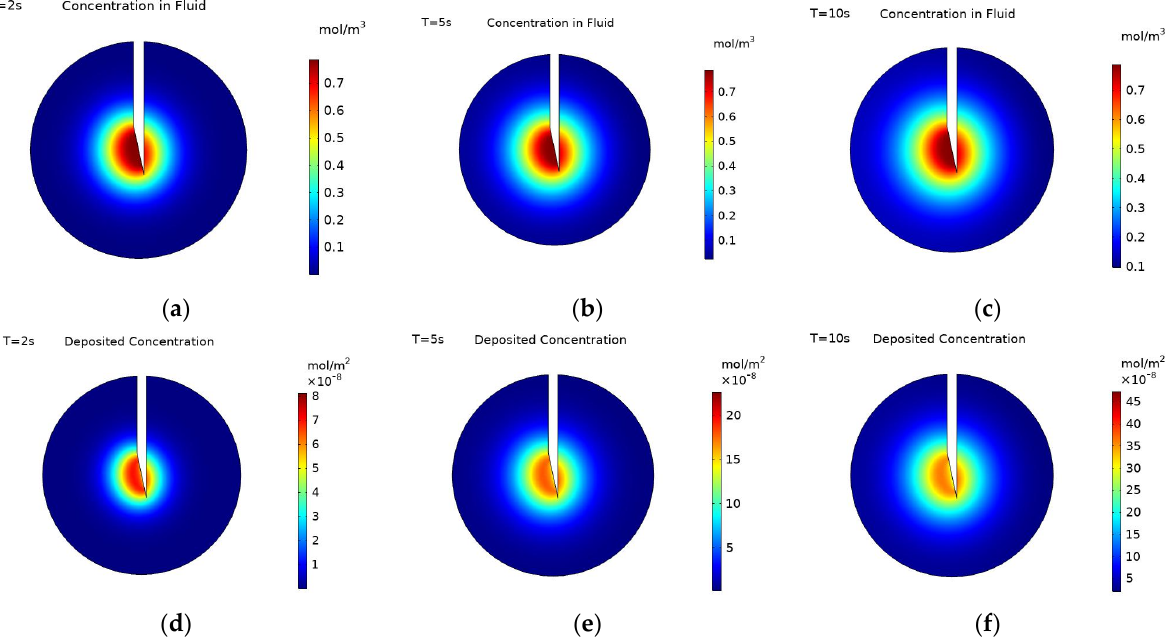
Figure 3. Concentration contours of charged particles ( − 20 mV) within the fluid at: ( a ) 2 s, ( b ) 5 s, and ( c ) 10 s during injection, and concentration contours of charged particles deposited onto cell surfaces at: ( d ) 2 s ( e ) 5 s, and ( f ) 10 s during injection. The cut plane is defined in Figure 2.